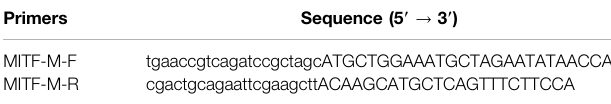
TABLE 1 | Primer sequences for cloning rabbit MITF-M CDS. Primers